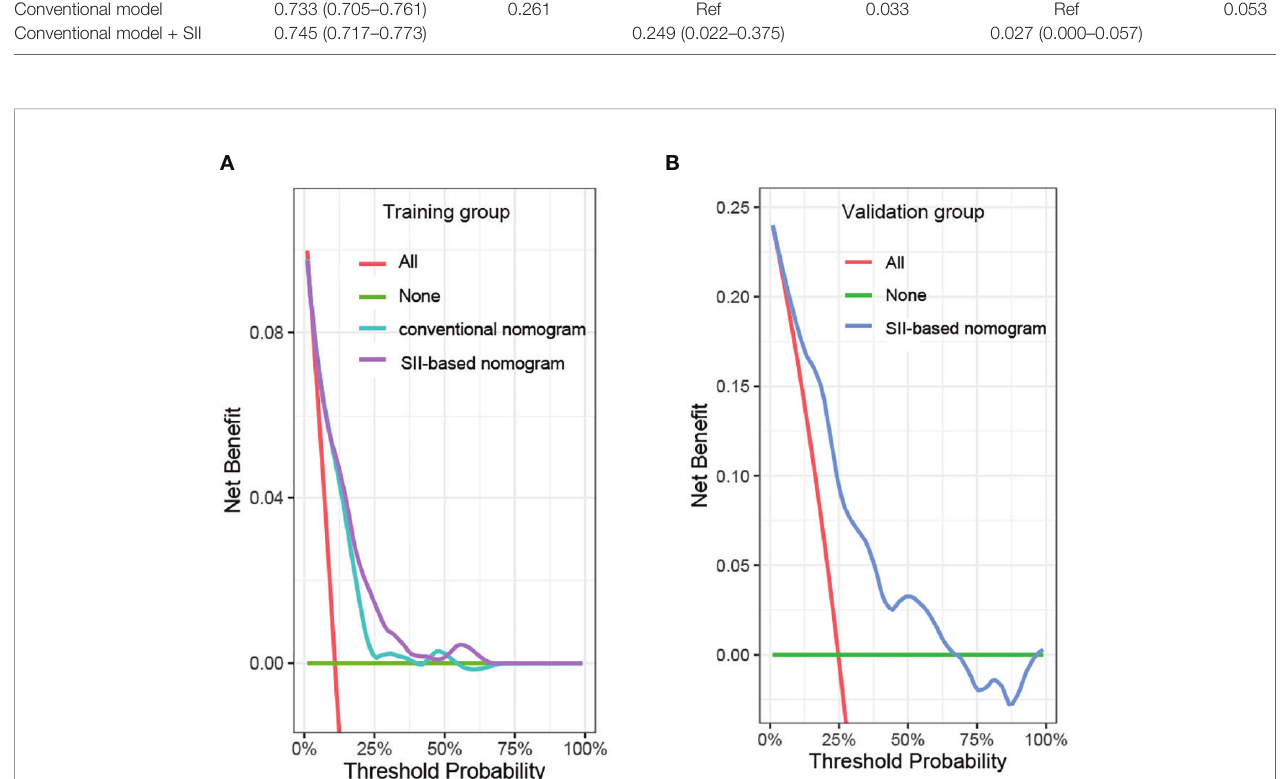
FIGURE 8 | Decision curve analysis of the prediction model in the (A) training group and (B) validation group. SII, systemic immune-in fl ammation